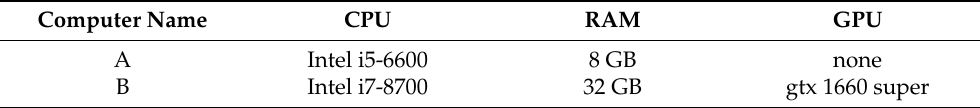
Table 1. Experiment environment.